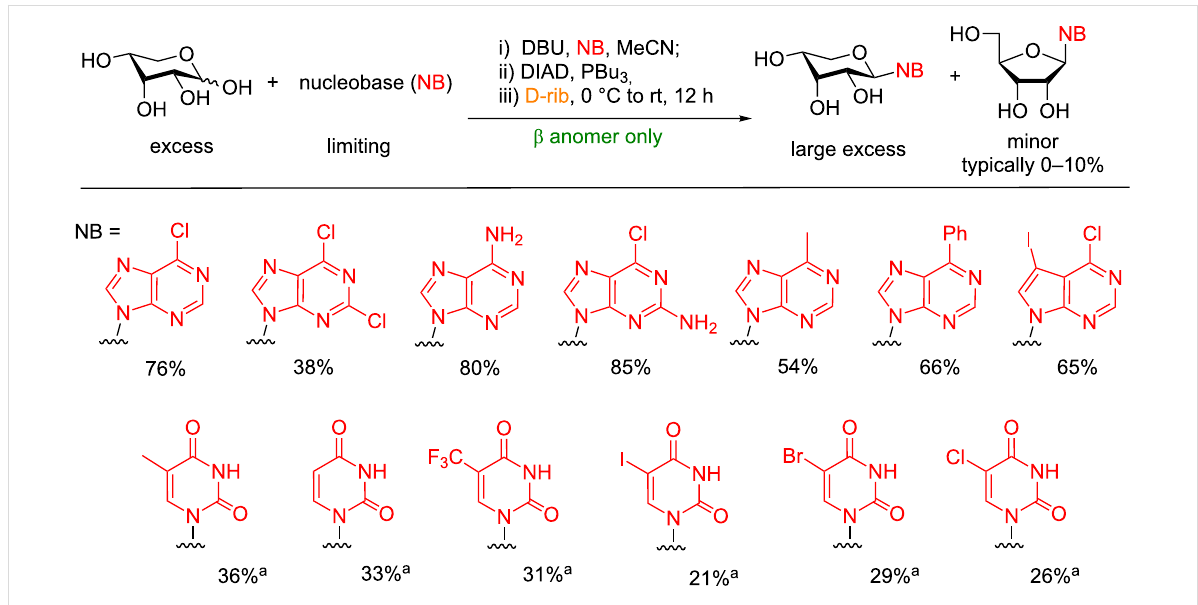
Figure 9: Direct synthesis of pyranosyl nucleosides from unactivated and unprotected ribose using optimized Mitsunobu conditions. a As determined by 1 H NMR. The products were inseparable from the furanoside using silica gel chromatography. DIAD = diisopropyl